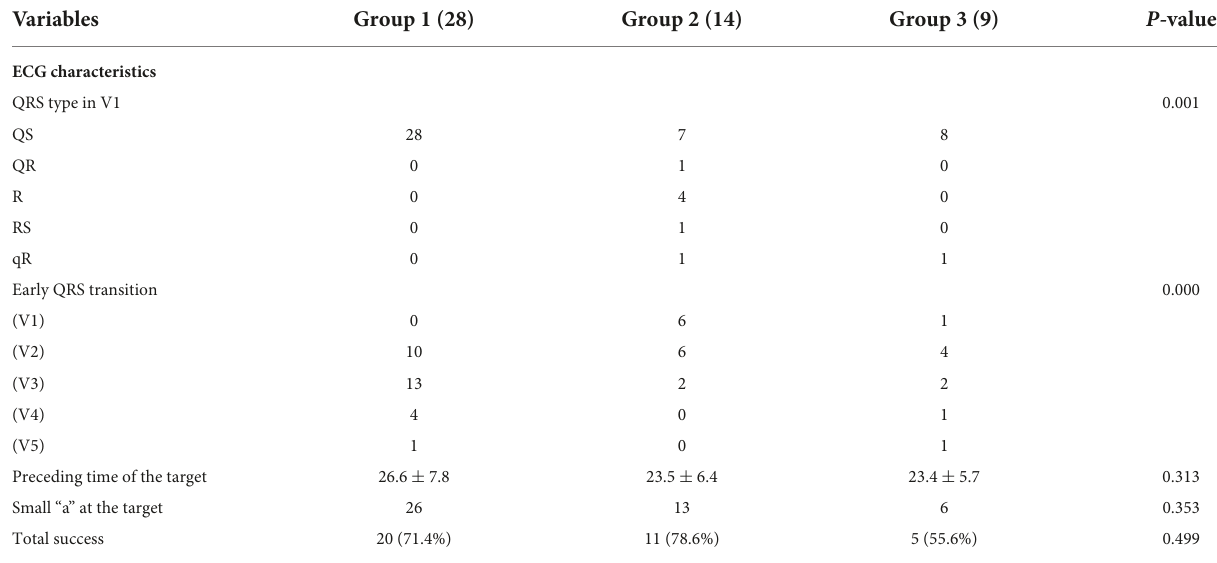
TABLE 2 Comparisons of ECG and electrophysiological characteristics of VAs in basal septum between the right side (Group 1), left side (Group 2) and intramural foci (Group 3). Variables